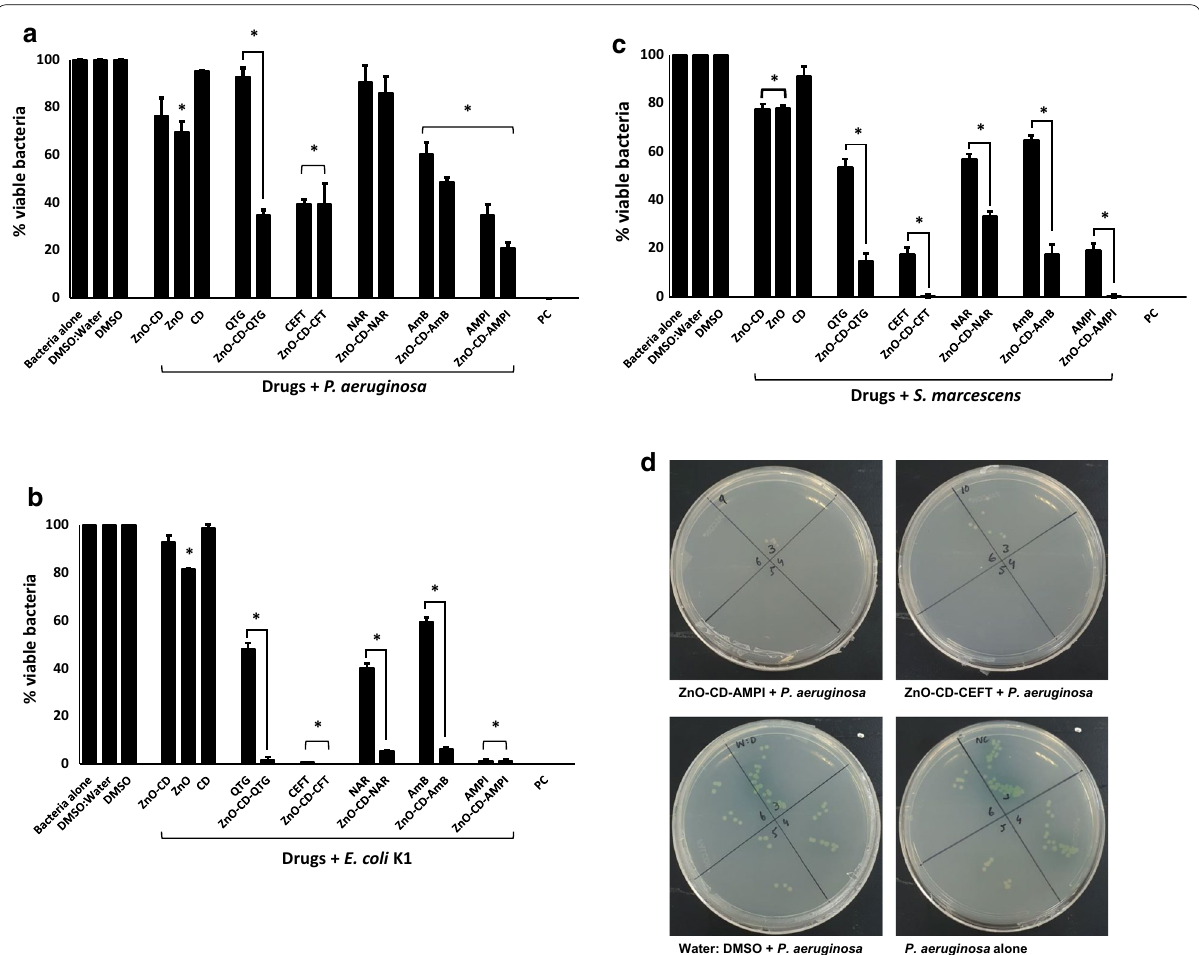
Fig. 7 Treatment with ZnO-NPs loaded with various drugs eliminated Gram-negative pathogenic bacteria. Briefly, ZnO-NPs and drug conjugates were mixed with test bacteria for 120 min at 37 °C. After this incubation, cultures were serially diluted and plated on nutrient agar plates. The plates were incubated at 37 °C for 24 h and subsequently viable bacteria were counted upon this incubation. For controls, bacteria incubated alone in PBS and with gentamicin (100 µg/mL) was used as negative and positive controls, respectively. ZnO-NPs conjugated drugs showed remarkable antibacterial properties against Gram-negative bacteria. The data are representative of several experiments performed in duplicate and expressed as the mean standard error, where (*) represent when P 0.05 ± ≤